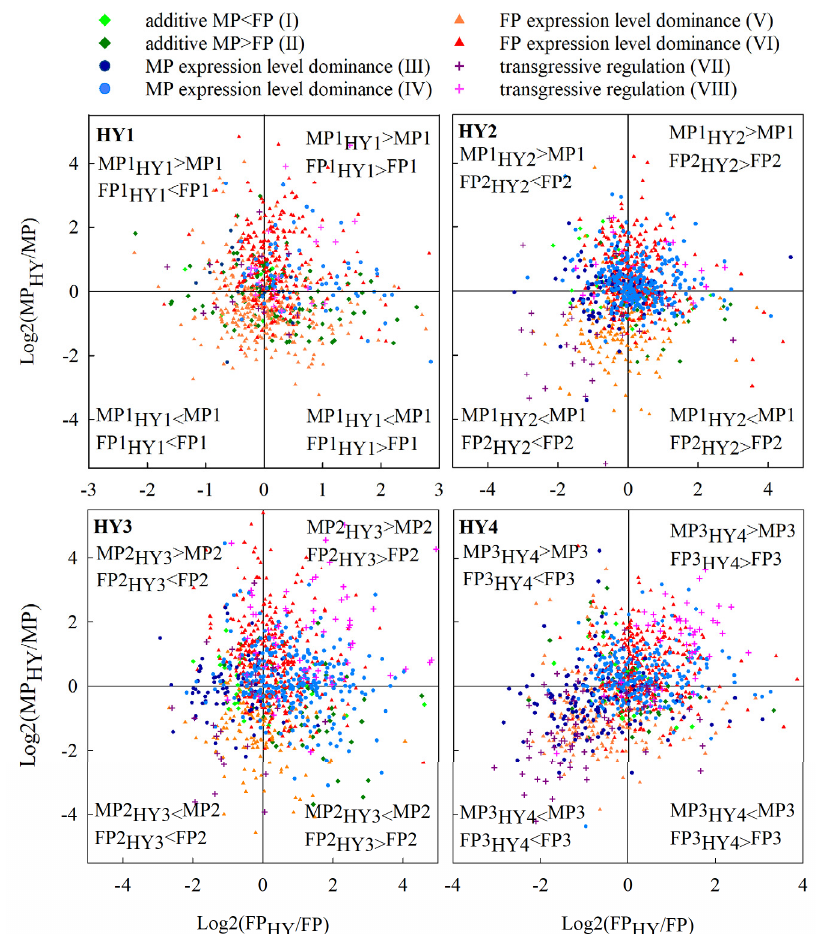
Figure 7. Allele-specific expression (ASE) variations of the differentially expressed genes (DEGs) in the hybrids. Each point in a plot represents a single gene. The position of each point represents the combined expression change of the two alleles in the hybrid with respect to the male (MP) and female (FP) parent.